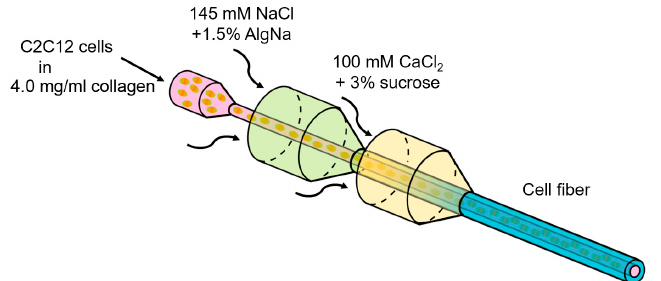
Figure 1. Schematic for fabrication of core-shell hydrogel microfibers. The C2C12 cell-laden core-shell hydrogel microfiber was formed by the double co-axial laminar flow.